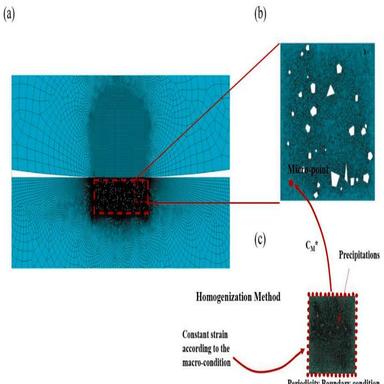
A schematical diagram of multi-scale analysis: (a) partial macro-model, (b) the detail of micro-voids and (c) RVE for homogenization method.